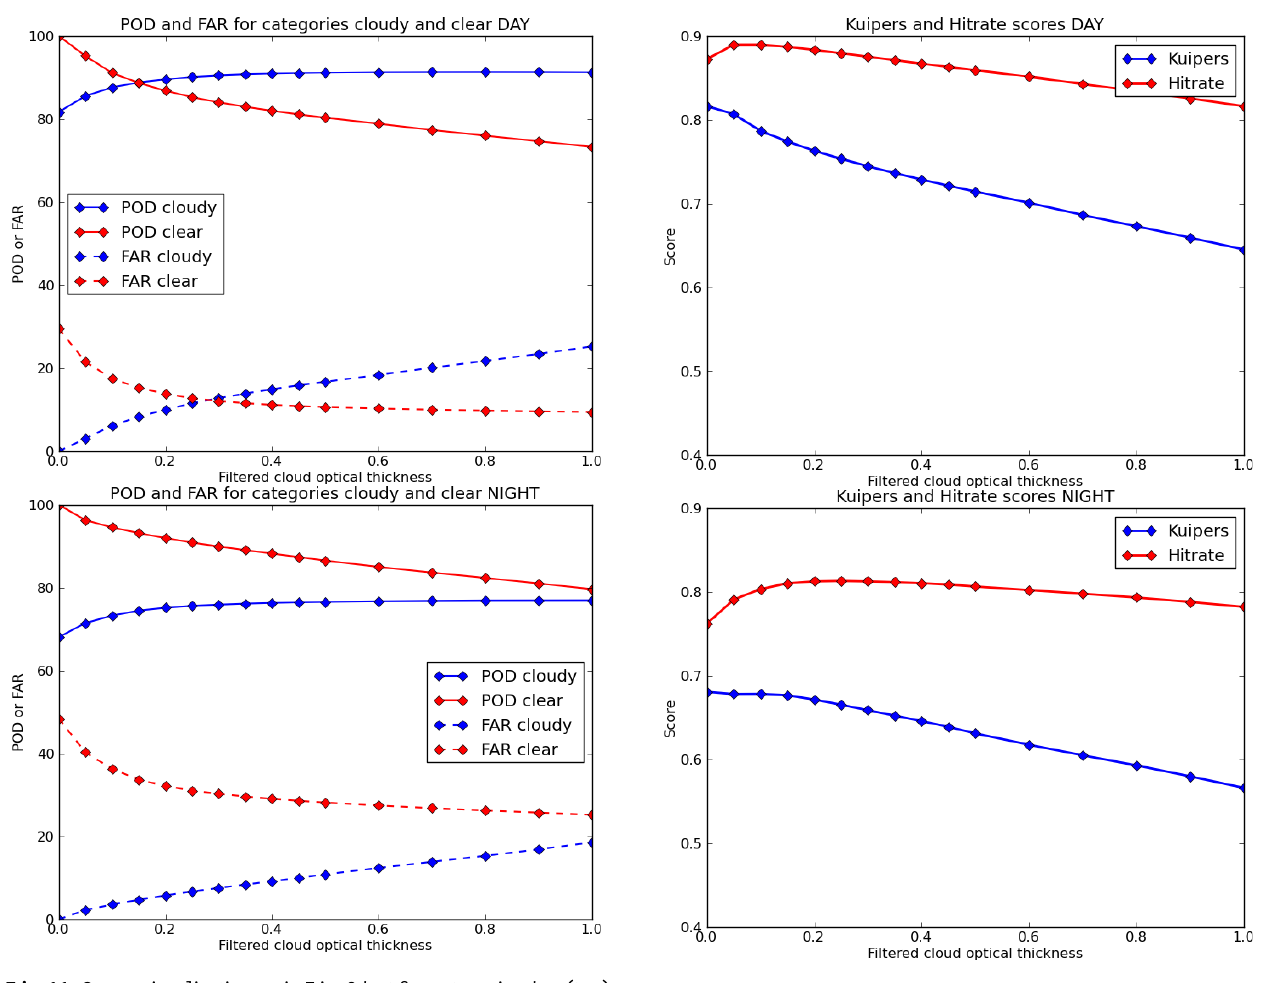
Fig. 12. Same visualisation as in Fig. 9 but for categories day (top) and night